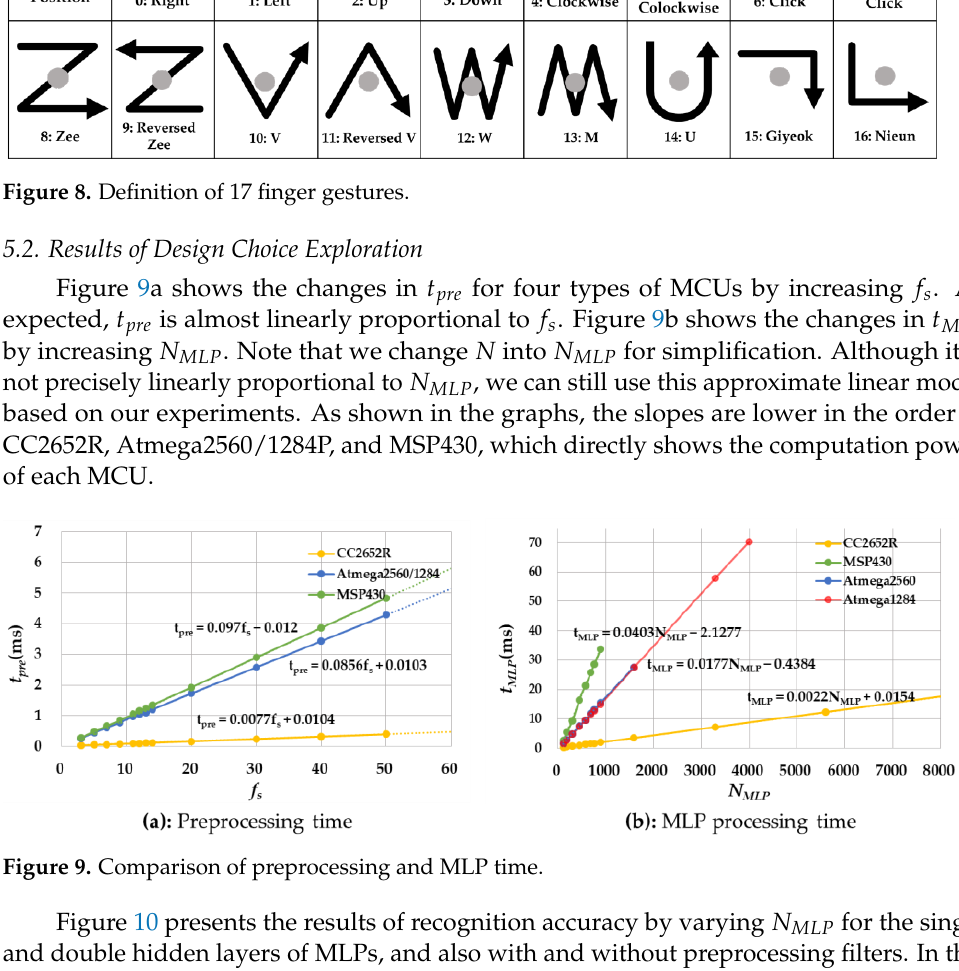
Figure 8. Definition of 17 finger gestures.